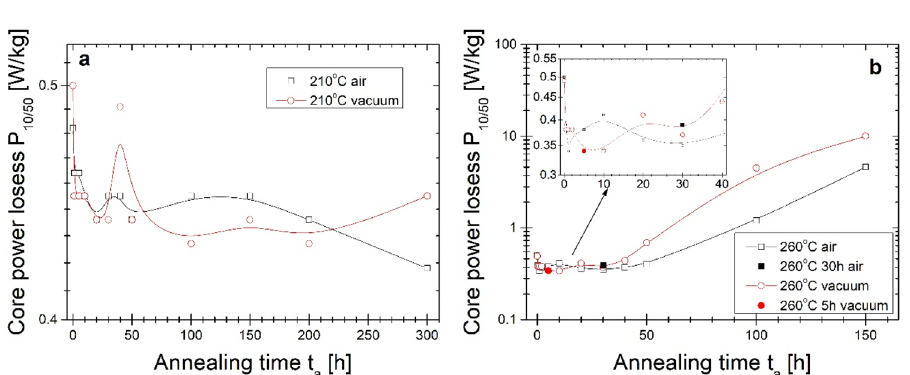
Figure 9. Core power losses P 10/50 on annealing time of isothermal annealing process at ( a ) 210 °C and ( b ) 260 °C.